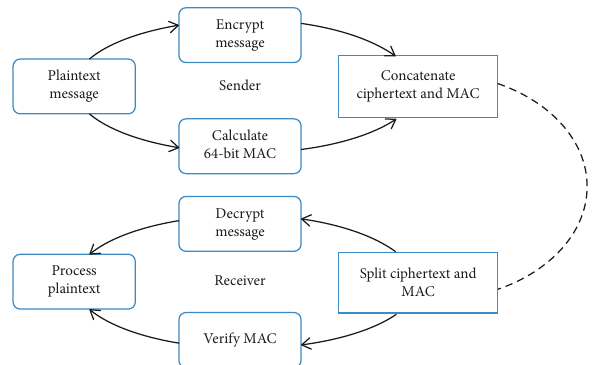
Figure 3: Flow chart of the implemented communication